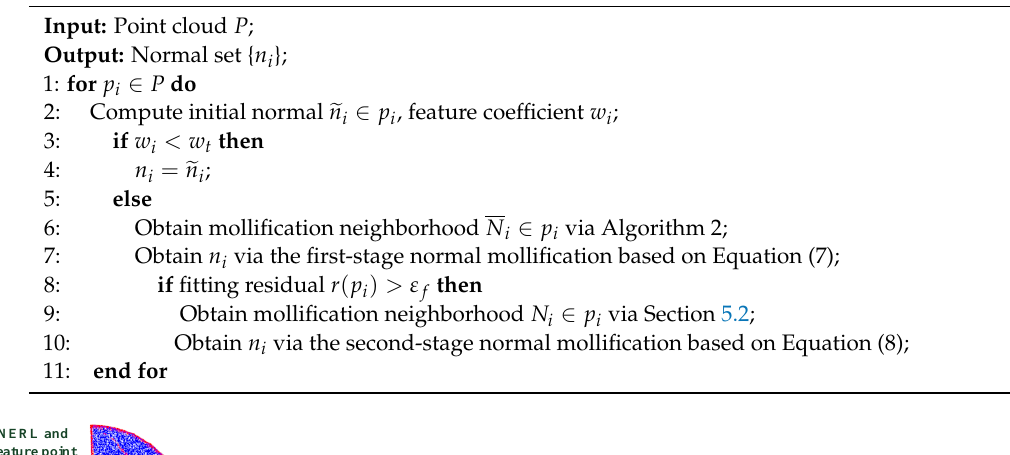
Algorithm 1 The pipeline of our algorithm